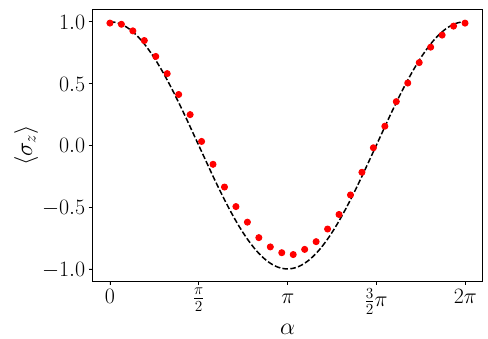
FIG. 6. Expectation value of σ z for a single qubit initialized in (α) gate. Red dots, experimental | 0 (cid:2) after the application of a R Y result; dashed line, theoretical